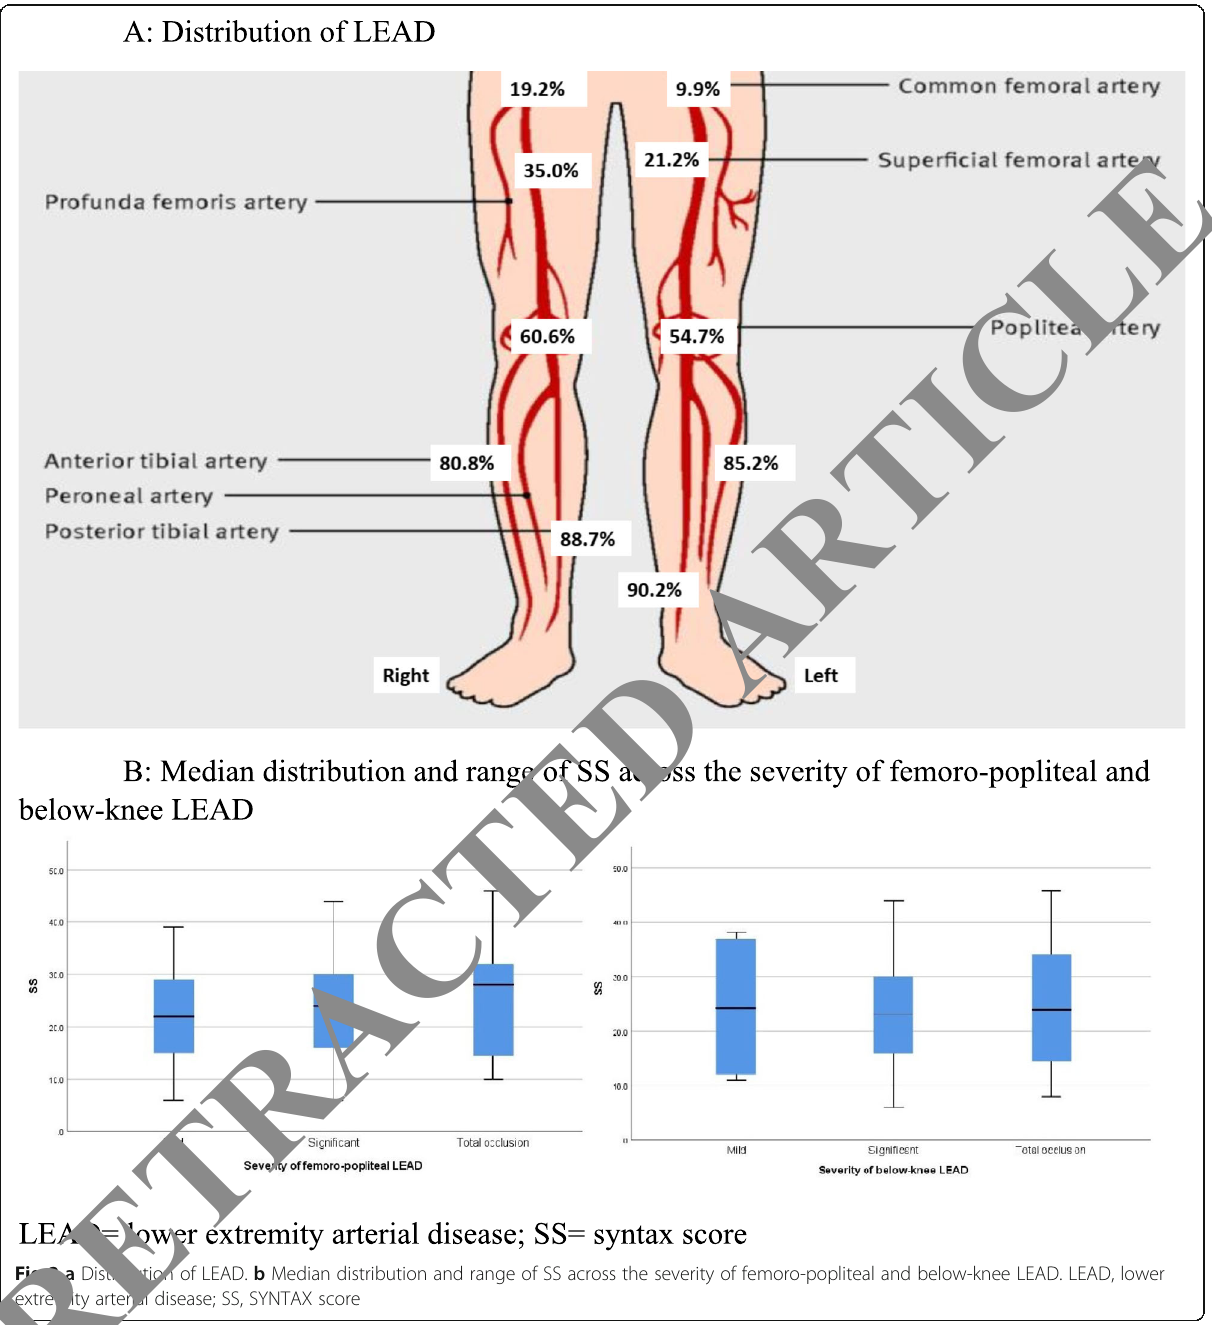
Fig 2 a Distribution of LEAD. b Median distribution and range of SS across the severity of femoro-popliteal and below-knee LEAD. LEAD, lower extremity arterial disease; SS, SYNTAX